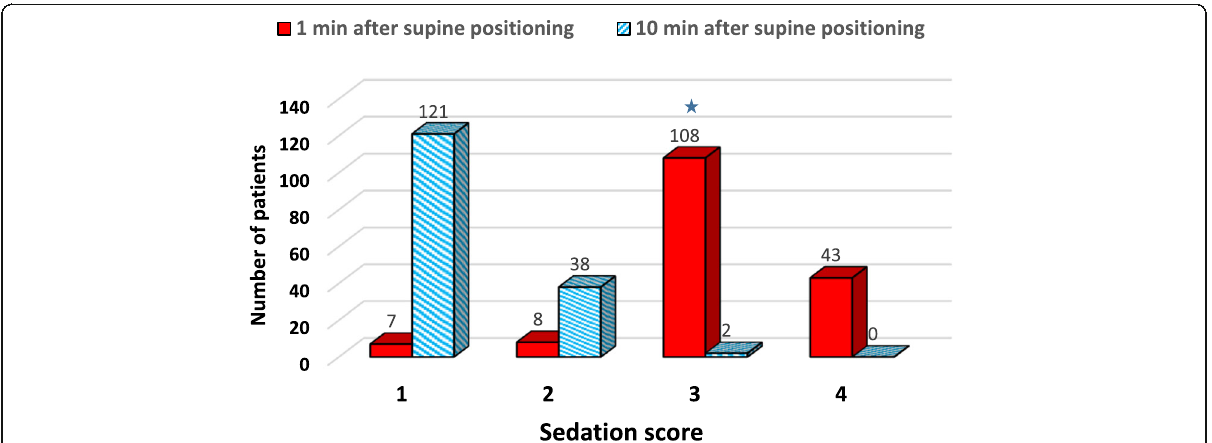
Fig. 6 The sedation score for the spinal group patients under PPS, 1 and 10 min after resuming supine position post spinal injection. Data are presented in number. n = 166. Ramsay score value 1 = patients are anxious, agitated; 2 = cooperative, oriented, and tranquil; 3 = only responds to commands; and 4 = asleep with a brisk response to glabellar